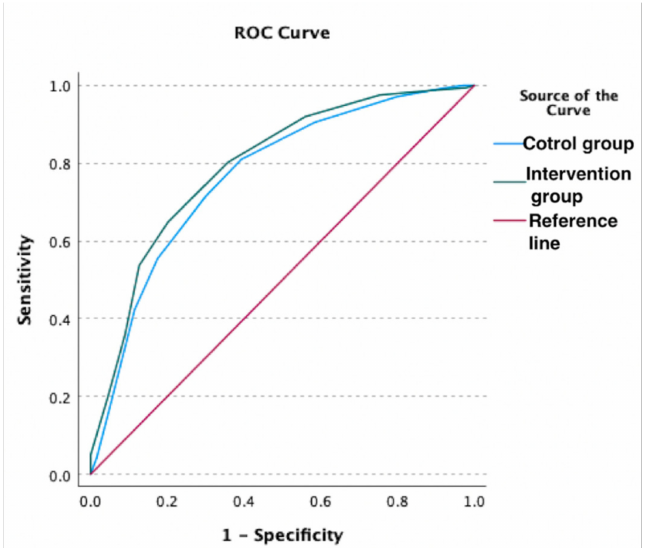
Figure 6. Receiver Operating Characteristics (ROCs) curve of patients’ understanding of the quiz and their radiology literacy outcomes for the control and intervention